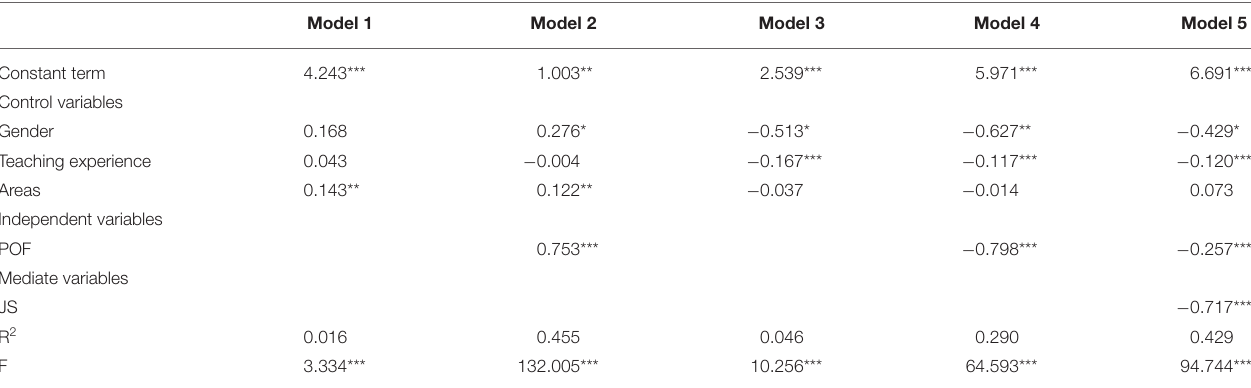
TABLE 3 | Regression analysis of the relationship among